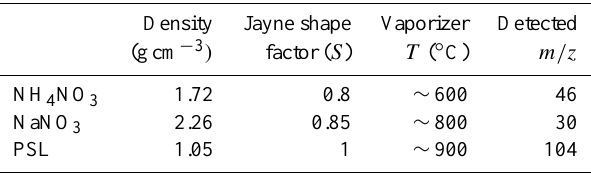
Table 3. Properties of materials used for the transmission efficiency